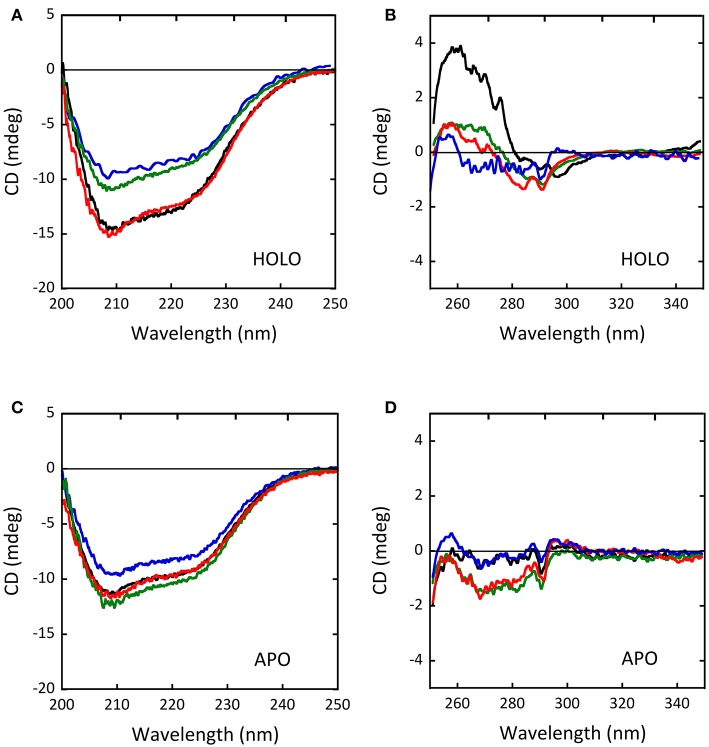
Comparison of the CD spectra of wild-type (black), G183R (blue), R199W (green) and R199Q (red) hDAAO variants. (A,C) Far-UV CD spectra of (A) the holoenzyme and (C) the apoprotein forms of the hDAAO variants (0.1 mg/mL protein concentration). (B,D) Near-UV CD spectra of (B) the holoenzyme and (D) the apoprotein forms of the hDAAO variants (0.4 mg/mL protein concentration). From (Caldinelli et al., 2013; Cappelletti et al., 2015; Murtas et al., 2017b).